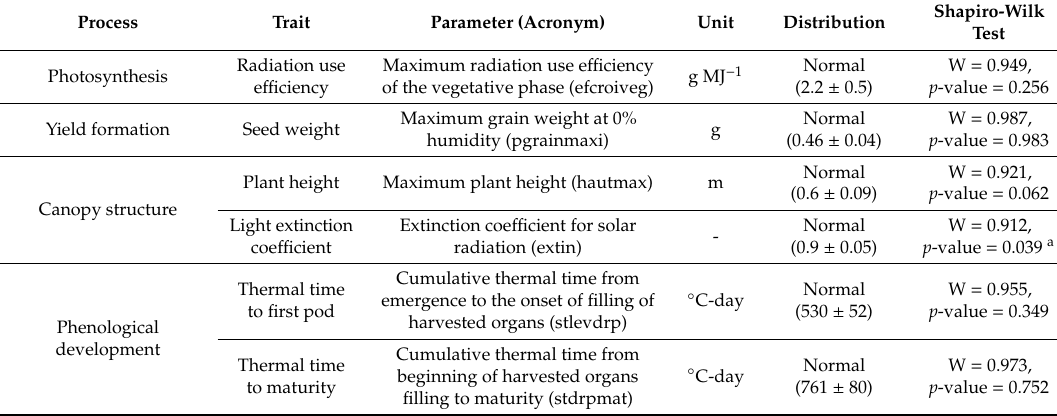
Table 1. Traits considered in the study, with corresponding STICS parameters and statistical distribution (mean ± standard deviation) derived from the characterization of 24 bean varieties. Results of the Shapiro–Wilk normality test are also